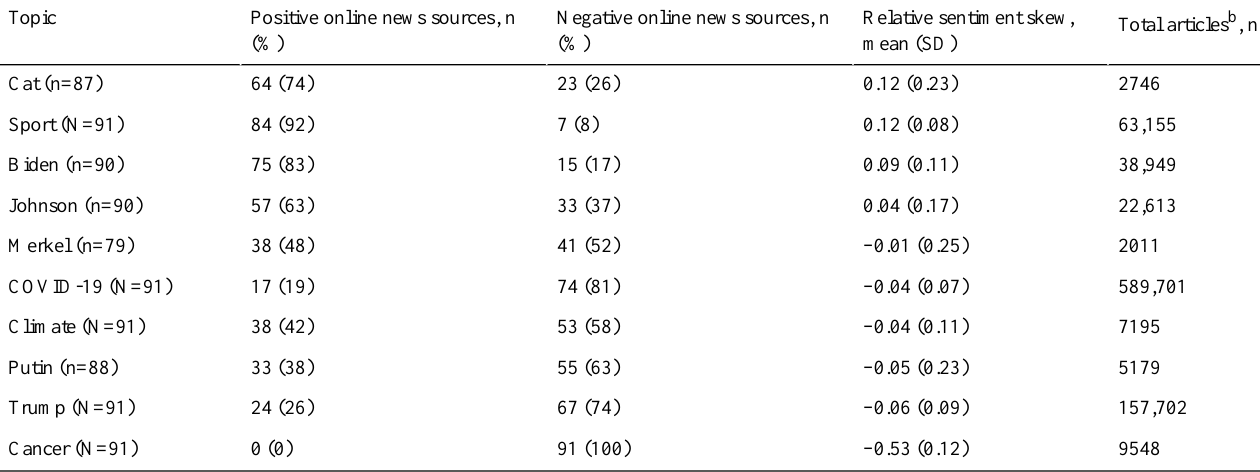
Table 4. English-language online news sources a , with positive ( ≥ 0) or negative (<0) relative sentiment skew of 2020 articles on a given topic.